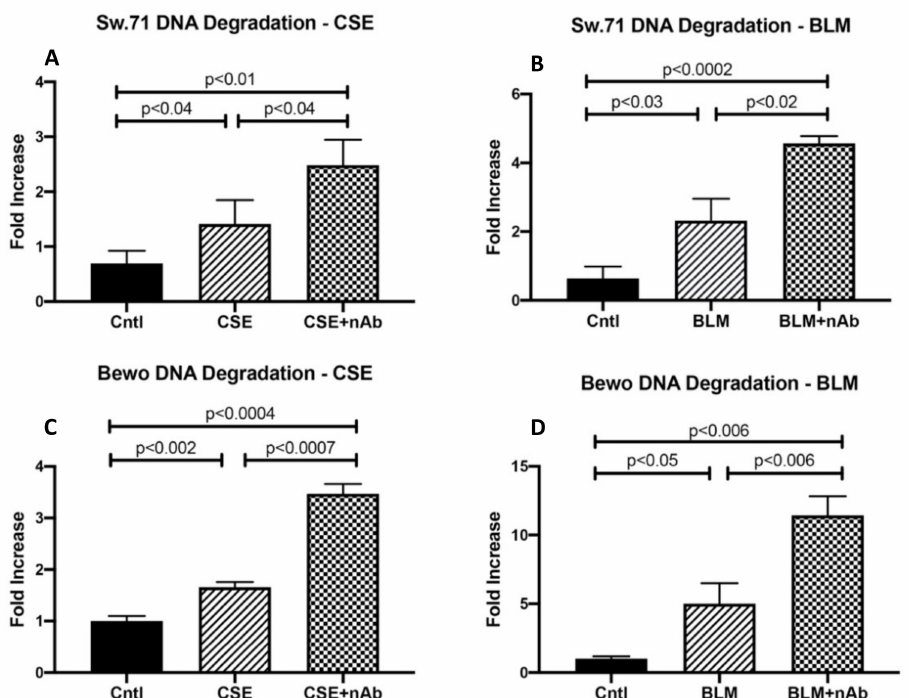
Figure 4. Role of RAGE in trophoblast DNA damage. ( A ) Increased DNA degradation in CSE treated Sw.71 cells. ( B ) Increased DNA degradation in BLM treated Sw.71 cells. ( C ) Increased DNA degradation in CSE treated Bewo cells. ( B ) Increased DNA degradation in BLM treated Bewo cells. ( A – D ), worsened DNA damage was present with the addition of neutralizing RAGE antibody in both cell types.